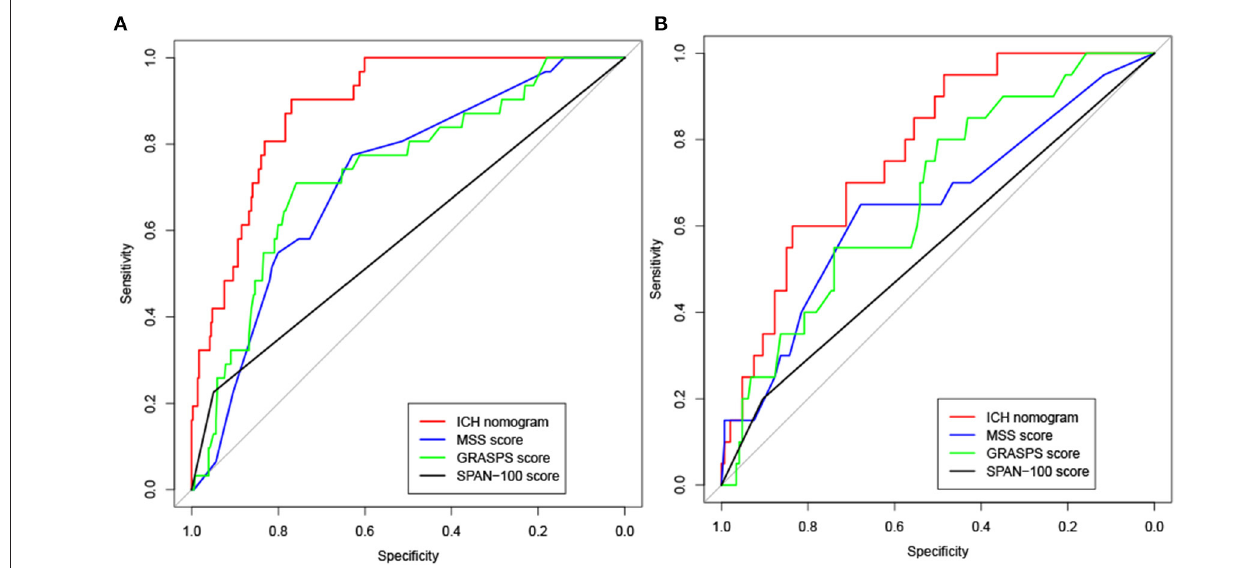
FIGURE 4 | Receiver operating characteristic (ROC) curve analysis for the ICH nomogram, MSS scores, GRASPS scores, and SPAN-100 scores in the training set (A) and testing set (B) . MSS (Multicenter Stroke Survey); GRASPS (Glucose, Race, Age, Sex, Systolic blood Pressure, and Severity of stroke); SPAN-100 (stroke prognostication using age and NIH Stroke Scale − 100 positive index).